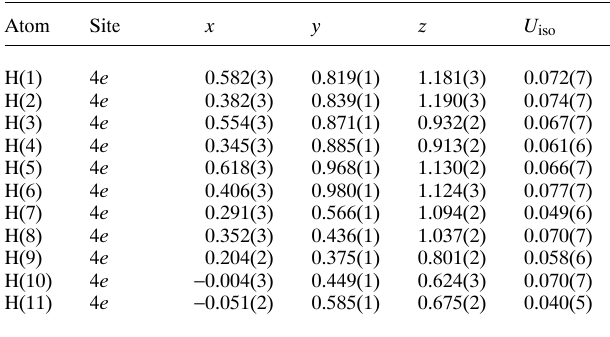
Table 2. A tomic coordin a tes a nd displ a cement p a r a meters (in Å 2 )